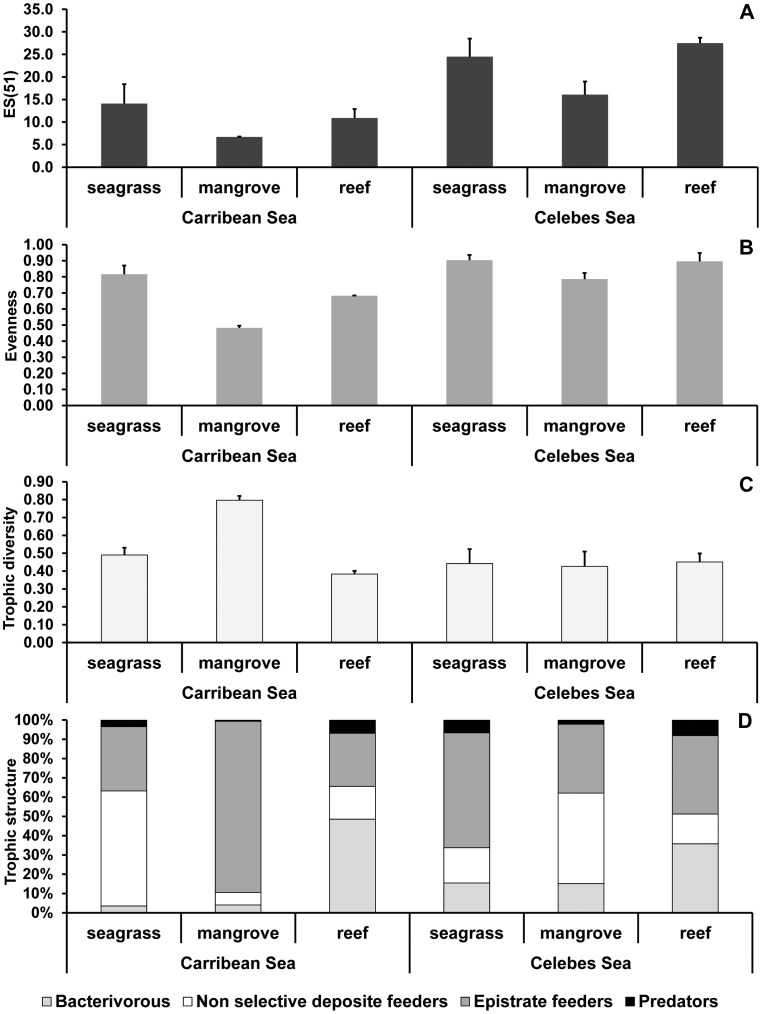
Nematode diversity.Illustrated are A) expected species number [ES(51)], B) evenness (Pielou’s J), C) index of trophic diversity (ITD) and D) trophic composition of nematode assemblages in seagrass, mangrove and reef habitats of the Caribbean, Red and Celebes Seas.